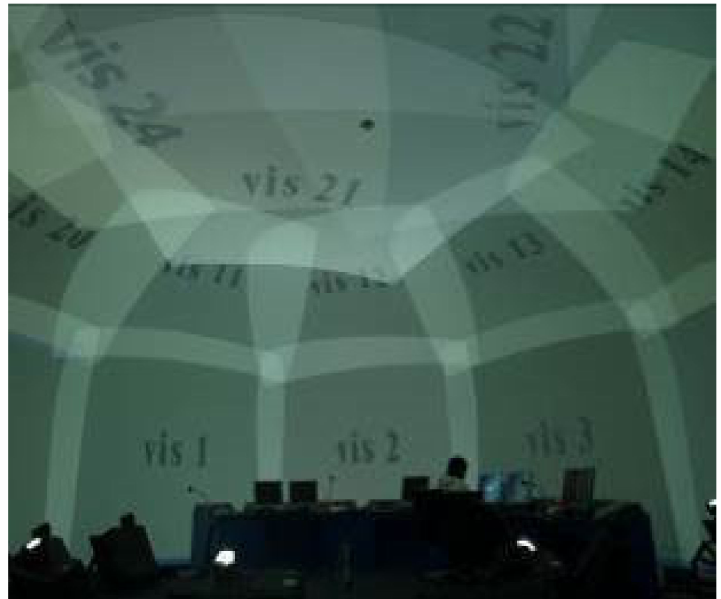
Figure 15. Dome-type screen projection